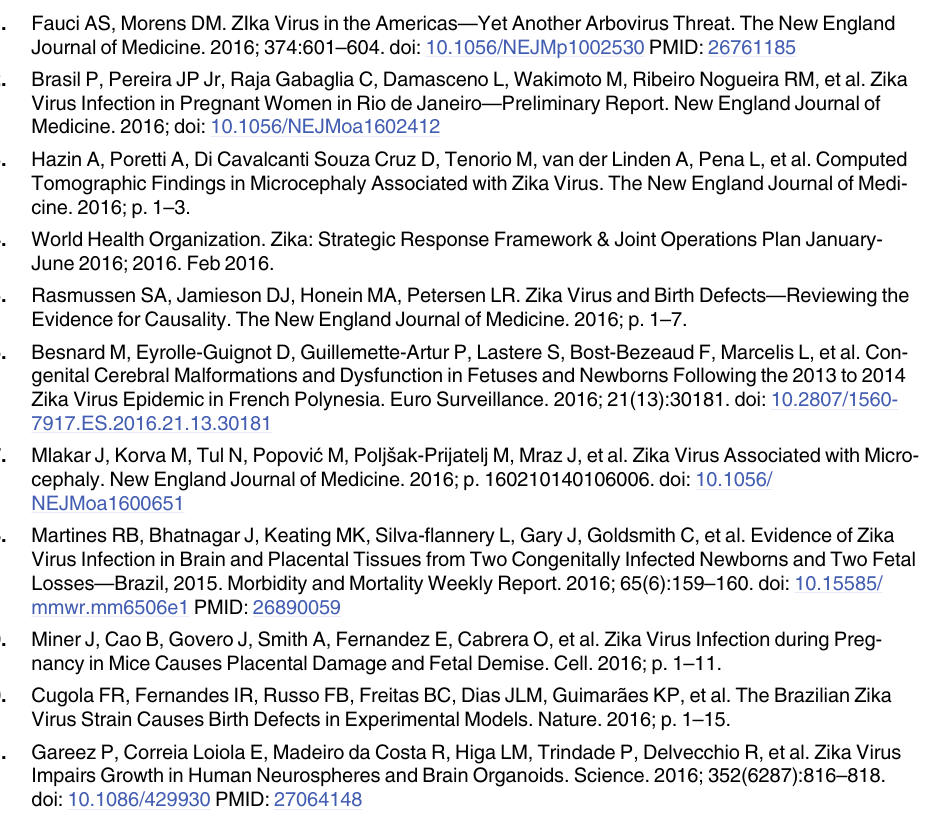
S6 Data. Fig 3B data. Time series produced using S5 Data and plotted in Fig 3B. S7 Data. Fig 3C data. Time series produced using S5 Data and plotted in Fig